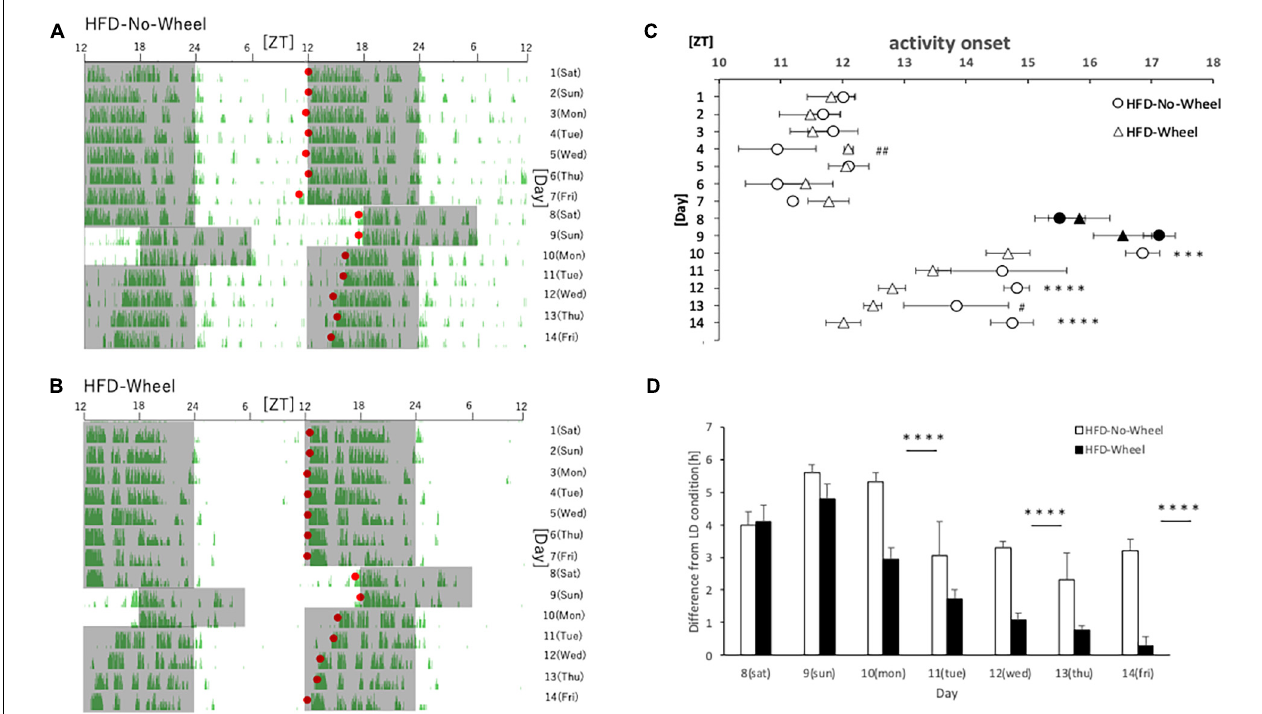
FIGURE 4 | Behavioral rhythm in the SJL condition during HFD feeding. (A) Typical double-plot actogram of behavior measured by the infrared sensor during one week of rearing under the normal LD condition (days 1–7) and one week of rearing under the SJL condition (days 8–14). On days 8 and 9, which are Saturdays and Sundays, the LD conditions were set back by 6 h. (B) Double-plot actogram of behavioral rhythms measured with a wheel-running device on a similar schedule. (C) Activity onset time was calculated from the daily activity rhythms and averaged per group. Saturdays and Sundays with different start of the dark period are indicated by black marks. Data are presented as mean ± standard error of the mean (HFD-No-Wheel, n = 10; HFD-Wheel, n = 8). (D) Difference between mean activity onset time during the first week (days 1–7) and activity onset time during the SJL condition (day 8–14). *** p < 0.001, **** p < 0.0001 ( t -test); # p < 0.05, ## p < 0.01 (Mann-Whitney